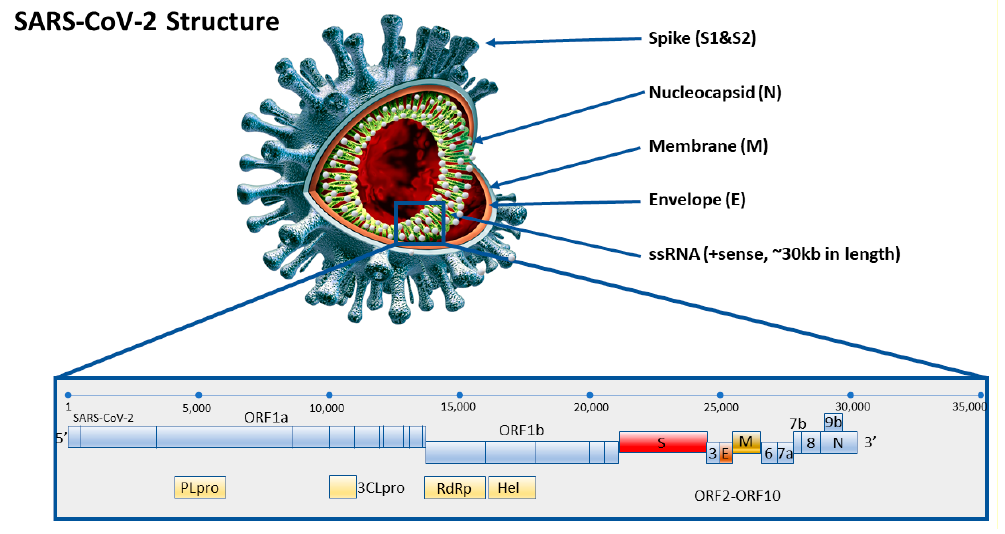
Figure 1. Real Time PCR COVID-19 genetic tests detecting ORF1ab, spike (S), envelope (E), or nucleocapsid (N) gene sequences of SARS-CoV-2 coronavirus (own interpretation, based on [8]).